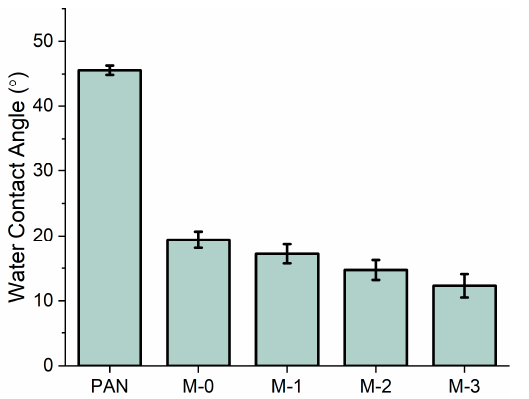
Figure 7. Water contact angle of the blank PAN, M-0, M-1, M-2, and M-3 membranes (measured by captive bubble method).